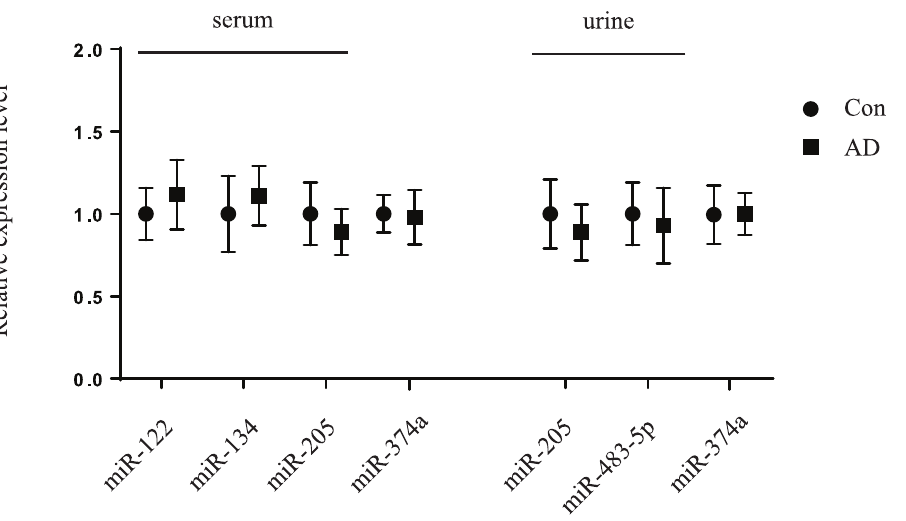
Fig. 3. Validation of other miRNA expression levels by quantitative real-time PCR. Selected miRNAs (miR-122, miR-134, miR-205 in serum and miR-205, miR-483-5p in urine) were measured in 30 children with AD and 28 healthy children. The 2 2 gg CT method in one subject with children with AD was normalized to 1. miR-374a expression levels in serum and in urine were considered as control. Data are presented as mean values ( ¡